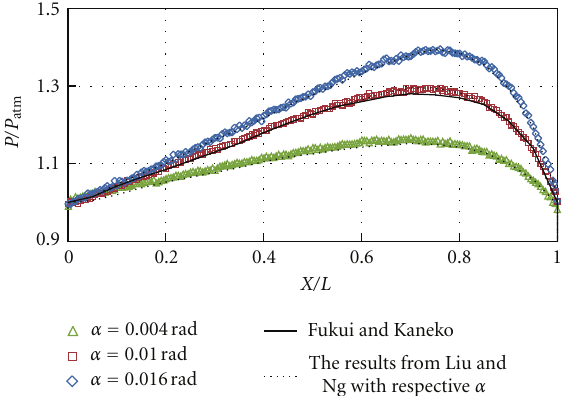
Figure 2: Comparison of pressure distributions on the slider surface from the present DSMC code, Liu and Ng [10] and the generalized lubrication equation solution of Fukui and Kaneko